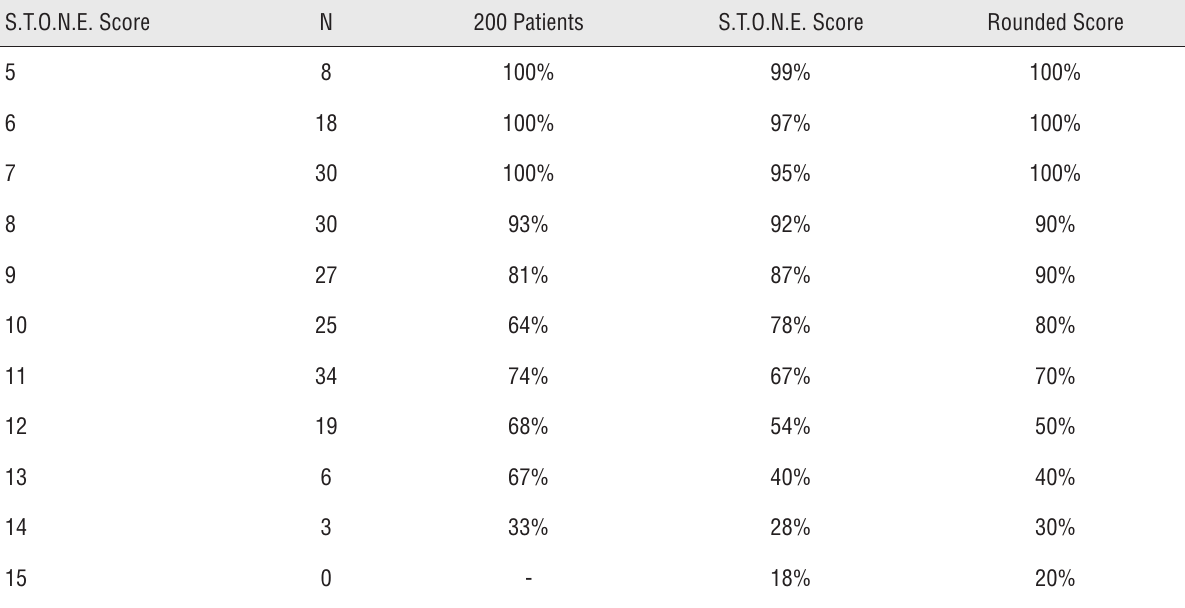
Table 3 - S.T.O.N.E. score compared to URS